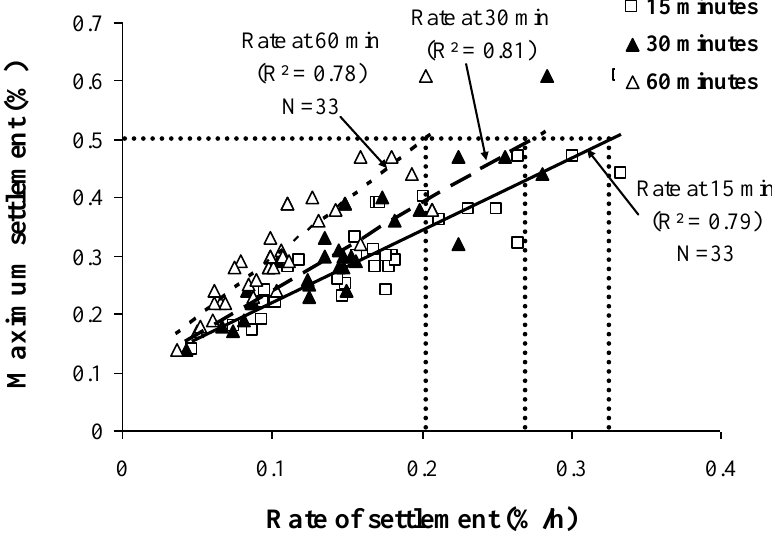
Figure 4. Relationship between rate of settlement and maximum